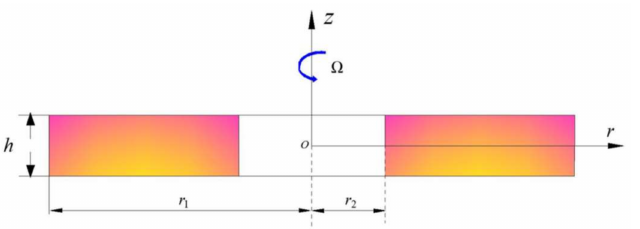
Figure 1. Schematic diagram of the cross-section rotating functionally graded nano-annular